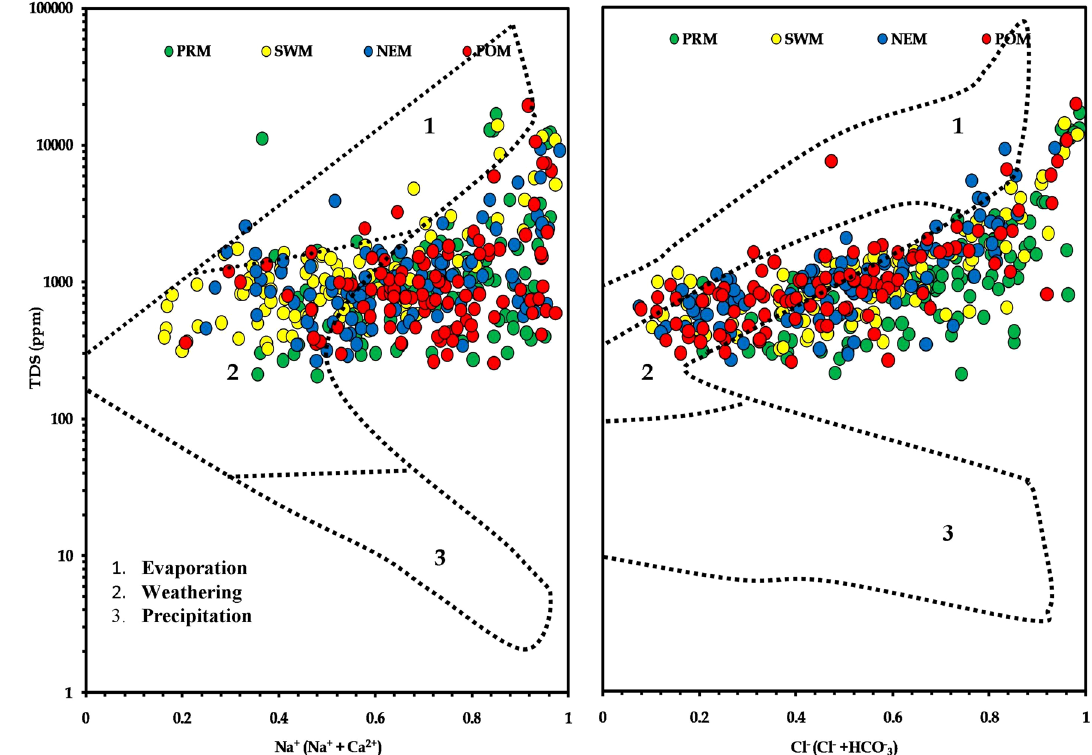
Fig. 3 Major ion chemistry showing nature of water (fields after Gibbs